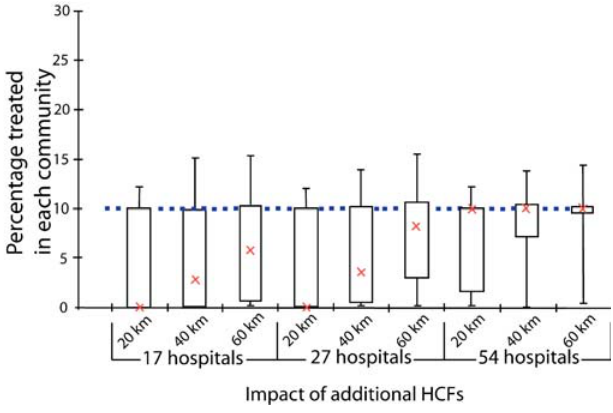
Figure 4. Percentage of People with HIV That Obtain Treatment per Community for Various Approaches Box plots of the percentage of infected people that obtain treatment per community for the three different sets of HCFs simulated in our analysis for ARV rollout, namely, using the 17 HCFs likely to be used, the 27 HCFs suggested by the South African government as potential implementation points, and all of the 54 hospitals in the KwaZulu– Natal province. These cases are represented for each of the three catchment region sizes we considered (with radii of 20 km, 40 km, or 60 km) and referenced against the ideal fraction treated (dotted blue line) under perfect conditions of egalitarian distribution, given the limited ARV supply. The red crosses indicate the median percentage of people with HIV that obtain treatment per community. DOI: